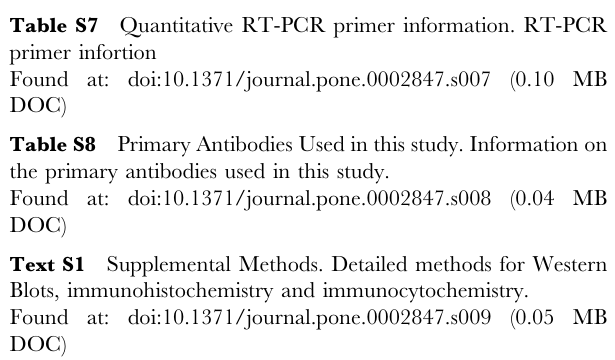
Table S1 Demographic information of normal donors. Demo- graphic information of CA and AA normal donor eyes used to generate primary cultures of ONH astrocytes.